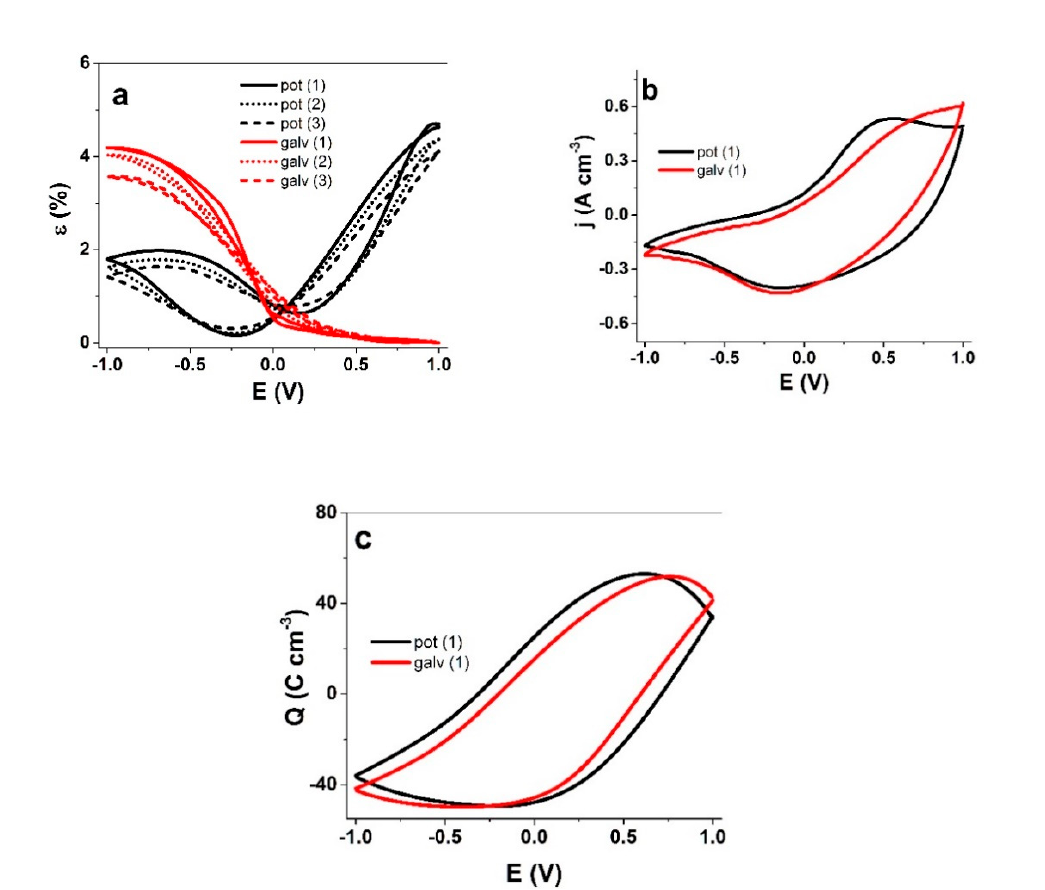
Figure 6. Cyclic voltammetry ( ± 1 V, 5 mV s − 1 ) driven linear actuation of PPy(pot) (black) and PPy(galv) (red) in a three- electrode cell with TBACF 3 SO 3 -PC solution The working electrode was the samples, counter electrode a platinum sheet and reference electrode a Ag/AgCl (3 M KCl). ( a ) strain ε of cycles (1) solid, (2) dotted, (3) dashed line; ( b ) current density j; ( c ) charge density Q against the potential E. The CV and charge density curves correspond to the strain curve (1).